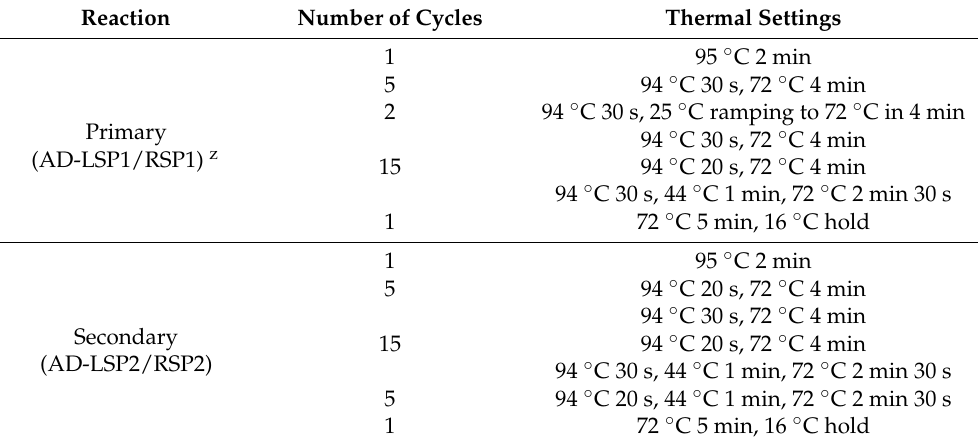
Table 2. Modified variable-argument–thermal asymmetric interlaced polymerase chain reaction (VA-TAIL PCR) conditions used in this study. Reaction Number of Cycles Thermal